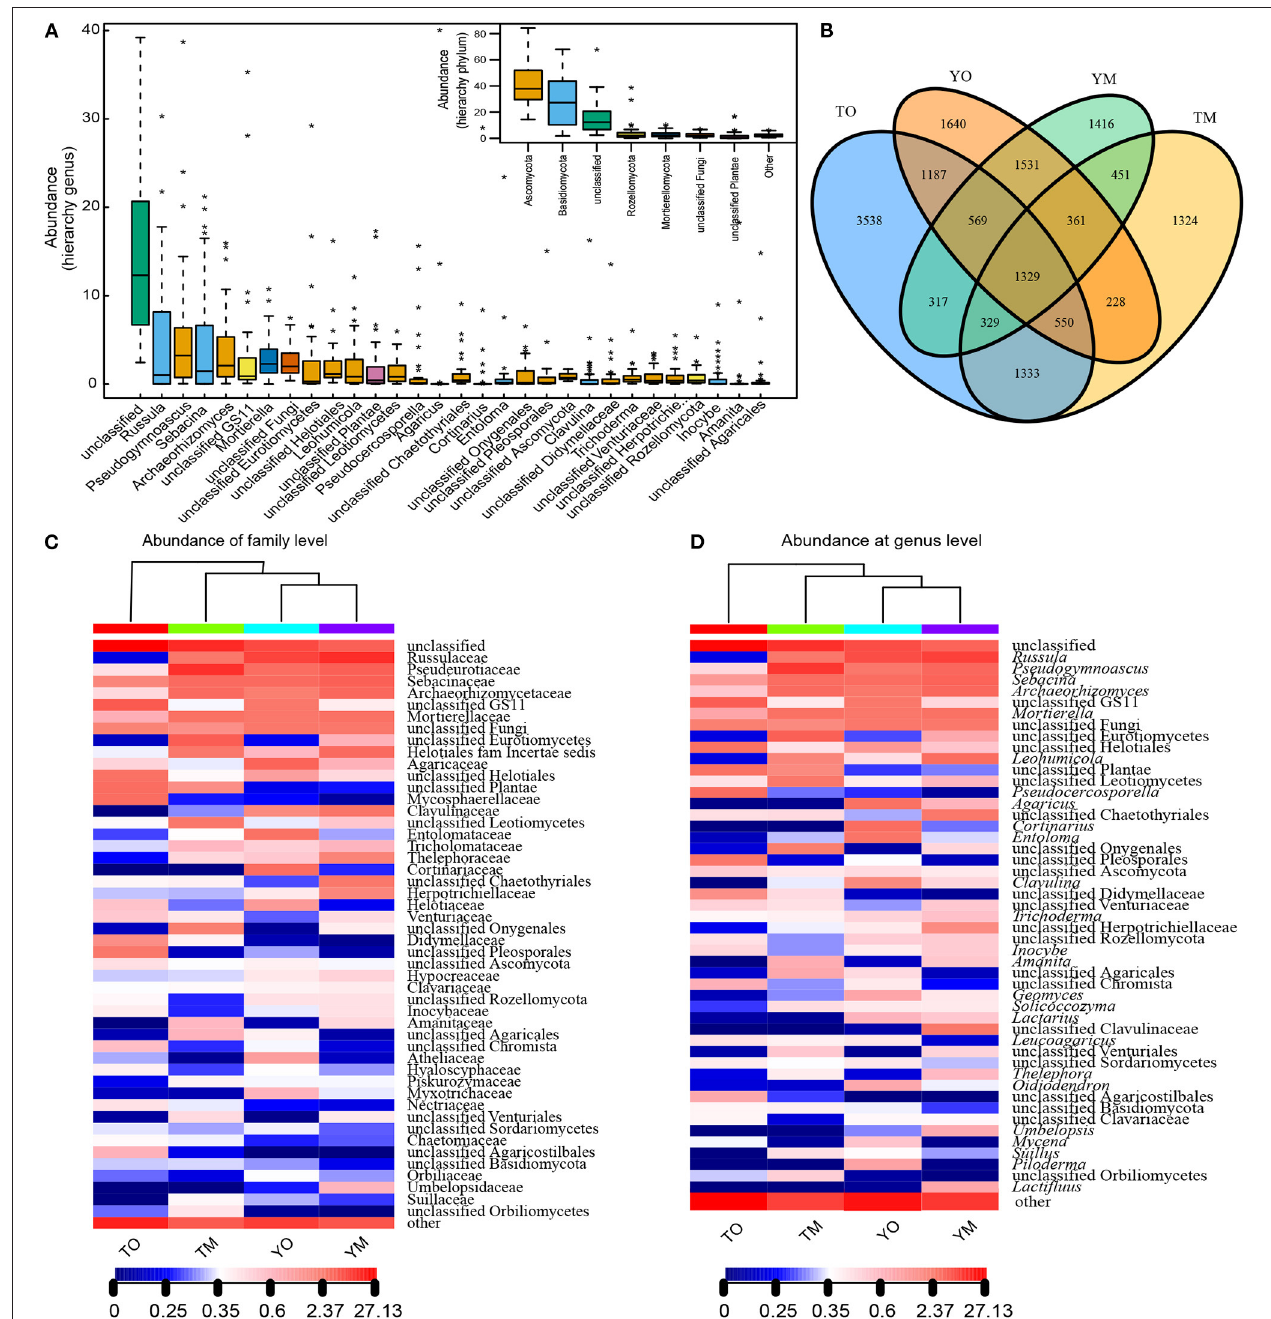
FIGURE 2 | Fungal abundance based on the hierarchy of genus and phylum (A) and Venn diagrams of shared and unique OTUs (B) in the O and M horizon at Dabie Mountain. UPGMA distance sample cluster tree and the fungal community composition based on family (C) and genus (D) level in the O and M horizon. TO represents the O horizon at Tiantangzhai Nature Reserve. TM represents the M horizon at Tiantangzhai Nature Reserve. YO represents the O horizon at Yaoluoping Nature Reserve. YM represents the M horizon at Yaoluoping Nature Reserve. significant difference between the two soil layers ( Figures 3C,D